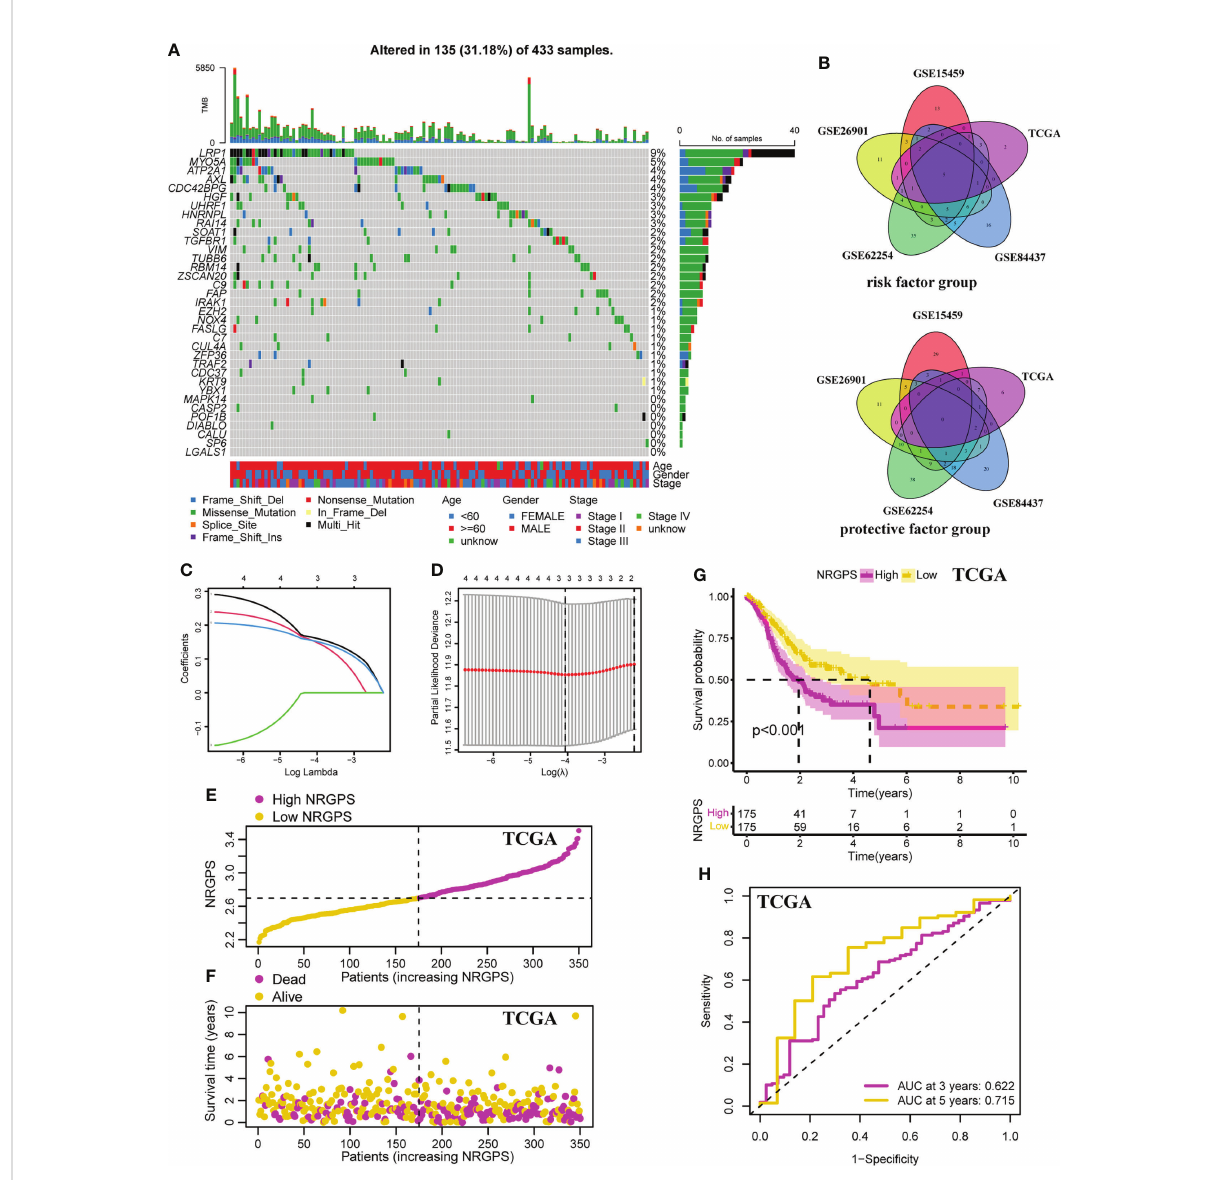
FIGURE 3 Development of the NRGPS System. (A) The waterfall plot of the prognostic associated genes mutations. (B) The venn plots of intersection of prognostic markers in fi ve cohorts were shown. (C) LASSO coef fi cient pro fi les of prognostic markers. (D) The tuning parameters were cross- validated in the LASSO model. (E) Distribution of NRGPS in TCGA cohort. (F) Survival status in the high-NRGPS and low-NRGPS groups of TCGA cohort. (G) Kaplan-meier survival analysis in TCGA cohort. (H) The ROC curve of TCGA cohort veri fi es the prediction ability of this prediction model. LASSO, Least Absolute Shrinkage and Selection Operator. NRGPS, necroptosis-related gene prognostic